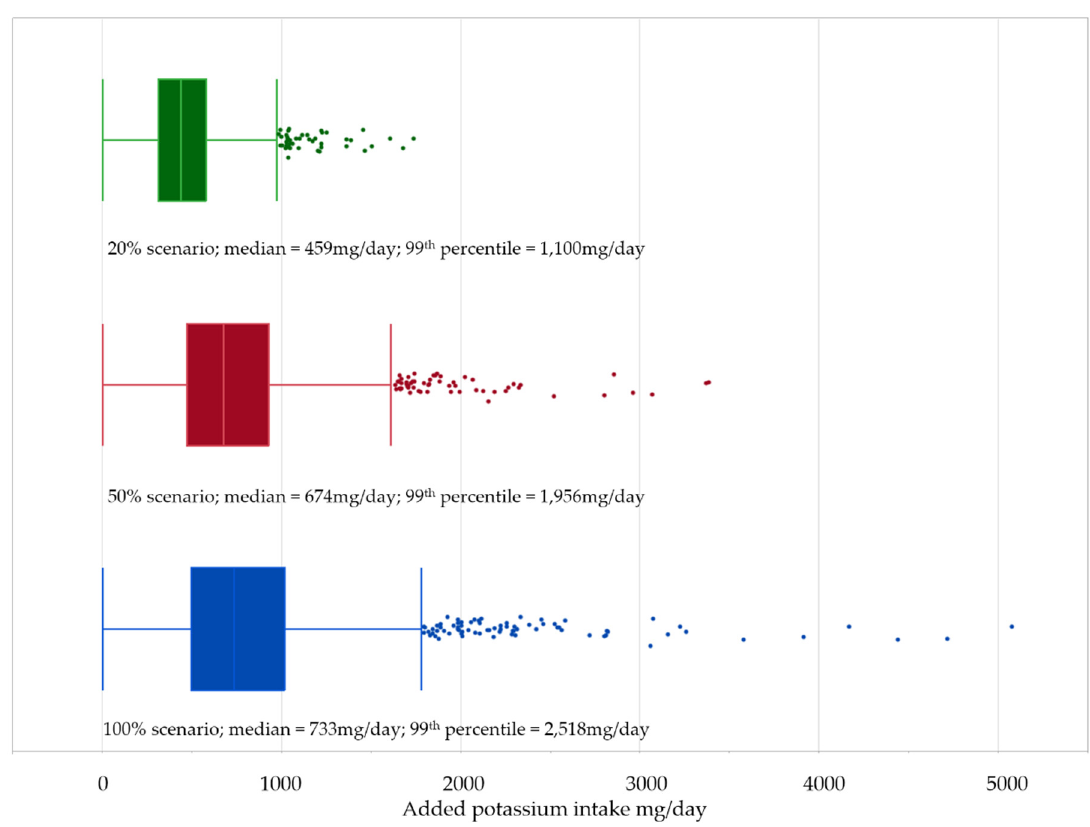
Figure 1. Intake distribution, combined for men and women showing the level of potassium added for each of the three reformulation scenarios.